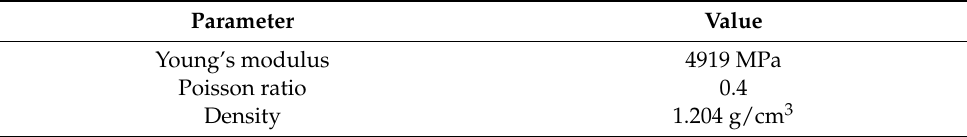
Table 2. Material properties of the material used in numerical models.